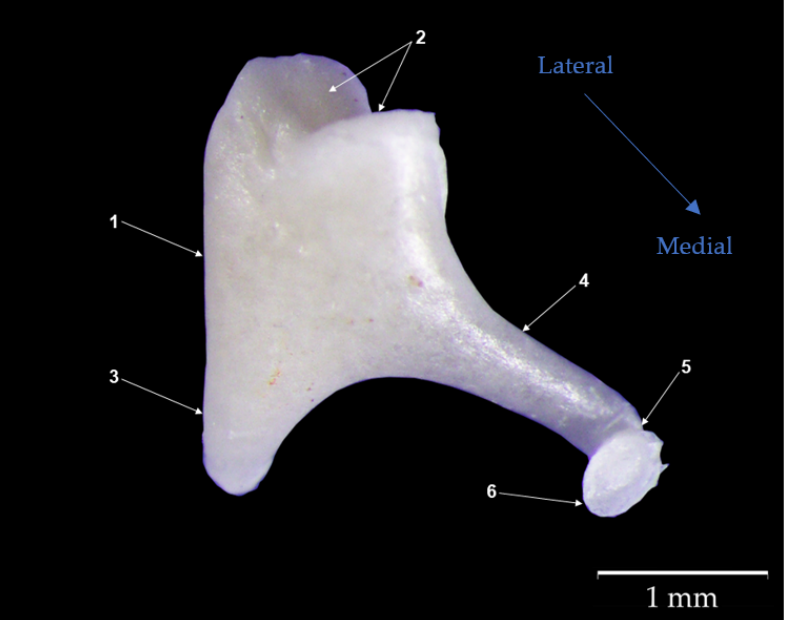
Figure 3. Anatomical features of the incus. (1) body of the incus ( Corpus incudis ); (2) malleal articular surface; (3) short crus ( Crus breve ); (4) long crus ( Crus longum ); (5) lenticular process ( Processus lenticularis ); (6) articular surface for the stapes. Table 4. Metric dimensions of the incudes in green monkey individuals.